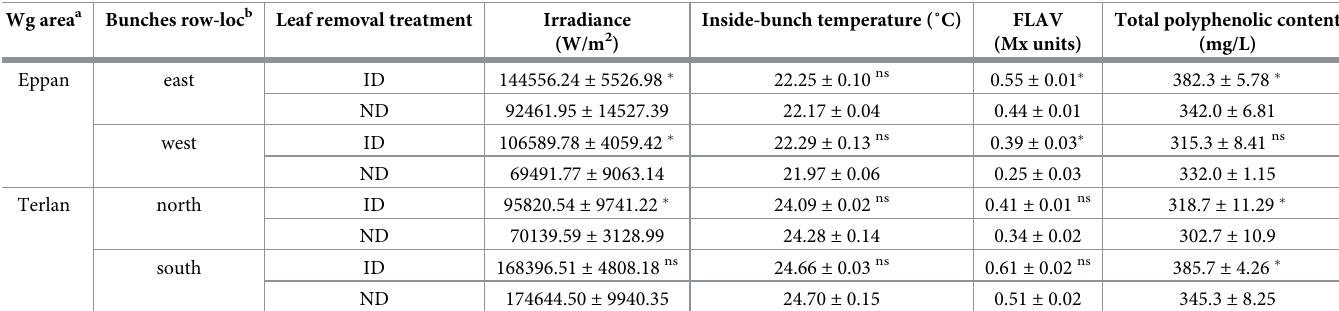
The reported microclimate parameters are the average of inside-bunch temperature (˚C) and total irradiance (W/m 2 ) recorded from DOY 185 to 243. The grape flavonol content and total polyphenolic content of grape juice (mg/L) were measured at DOY 243 by the FLAV index (Mx units) and the Folin-Ciocalteu method, respectively. Each value is the mean ± standard error of three replicates. For each grape row-localisation, asterisks indicate values that significantly differ (Student’s t - test; α = 0.05) in the pairwise comparison between intense defoliation (ID) and no-defoliation (ND) leaf removal treatments. a Wg area stays for winegrowing area.